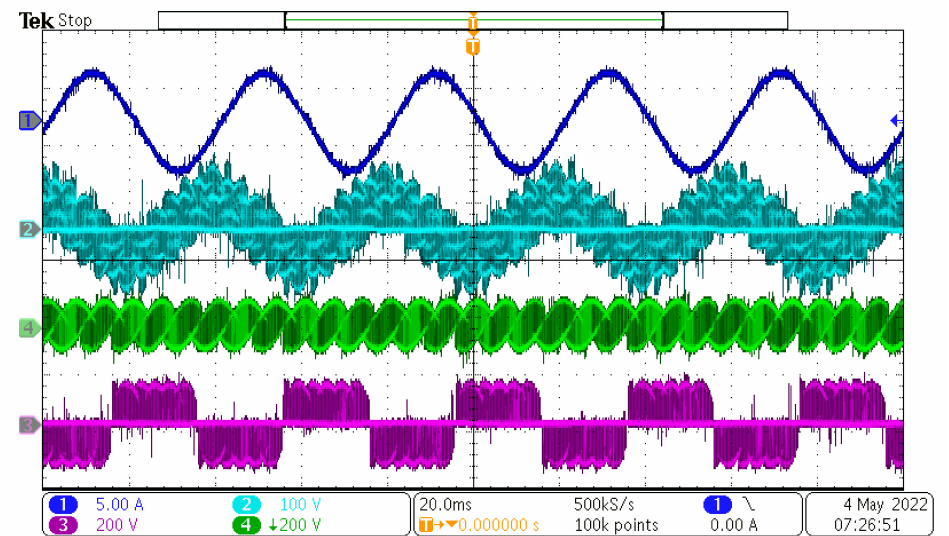
Figure 13. Measured results at f IN = 50 Hz and f OUT = 25 Hz. CH1—output current, CH2—output load voltage, CH3—output phase to phase voltage, CH4—output phase to input neutral voltage.